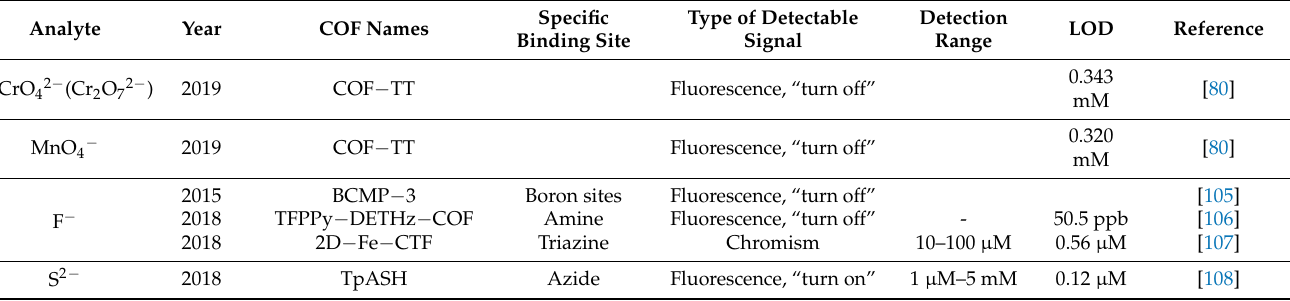
Table 5. COF-based anion